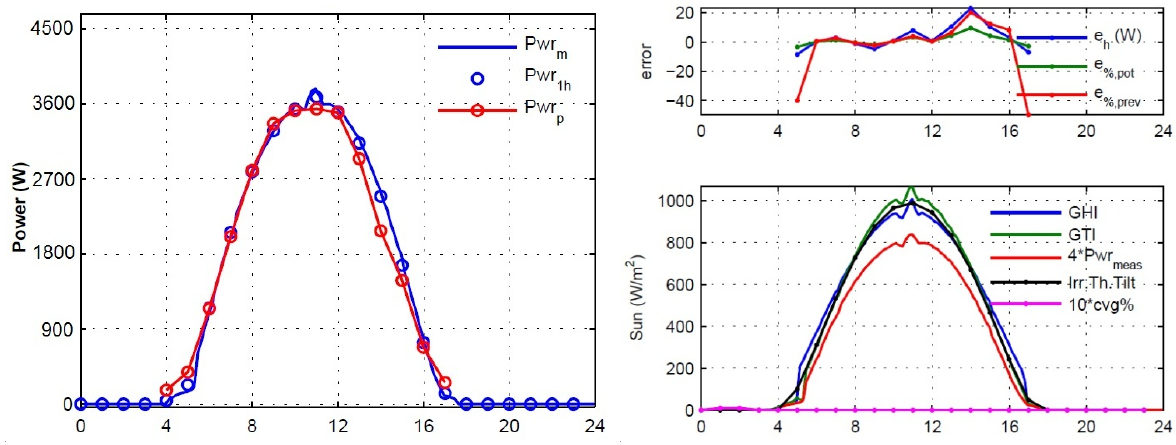
Figure 3. Daily detail of the curves of radiation (theoretical, forecast and actual) with the calculation of the error values during a clear sky